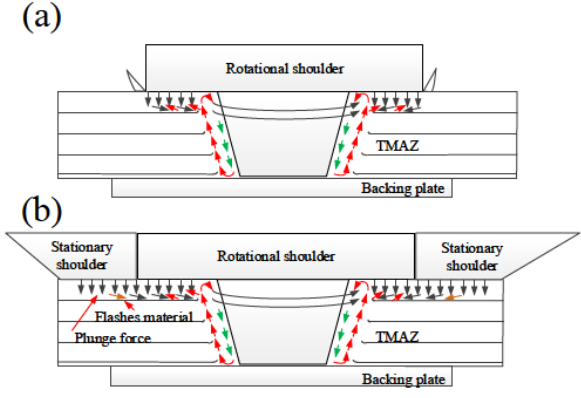
Figure 3: Material flow behaviors using different welding processes: (a) conventional FSW and (b)